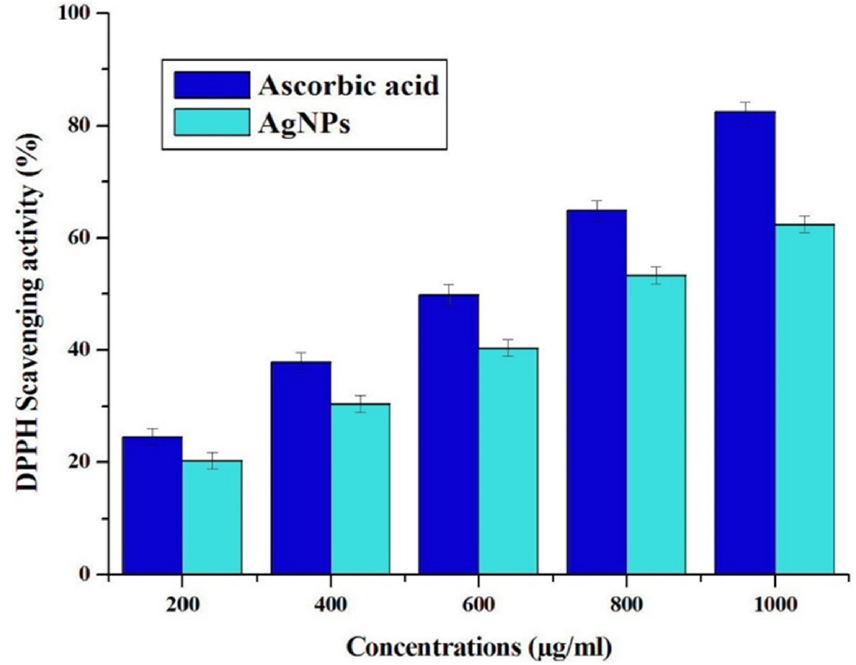
Figure 6. DPPH radical scavenging activity of Ag NPs assessed using ascorbic acid. The synthesized Ag NPs in this study were examined for larvicidal activity. It was found that Ag NPs showed significant larvicidal activity and LC50 and LC90 values were noted at the concentration of 0.742 and 6.061 ppm against Culex quinquefasciatus , respectively (Table 4). Ag NPs showed a maximum of 70% larvicidal activity against the tested larvae of Culex quinquefasciatus at 2 ppm concentration. The treated larvae exhibited restless movement and convulsion followed by death. There was no larval mortality in the controls, and all of the larvae were active and moved normally. In a study by Cecilia et al. [35], ecbolin A and ecbolin B compounds isolated from Ecbolium viride were tested against third instar larvae of Culex quinquefasciatus with the LC50 at the concentration of 7.22 and 1.36 ppm and LC90 at 14.49 and 2.76 ppm,